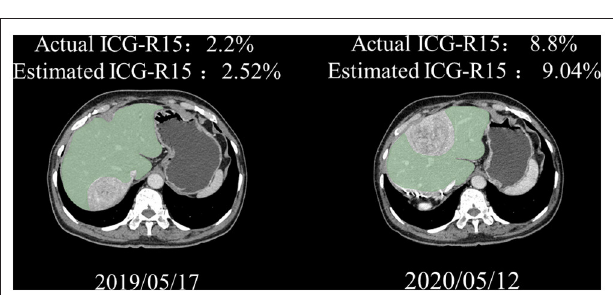
FIGURE 5 | Representative paired CT images of a 68-year-old man. Great agreement was observed between actual and estimated ICG-R15. ICG-R15, indocyanine green retention rate at 15min; CT, computed tomograph.